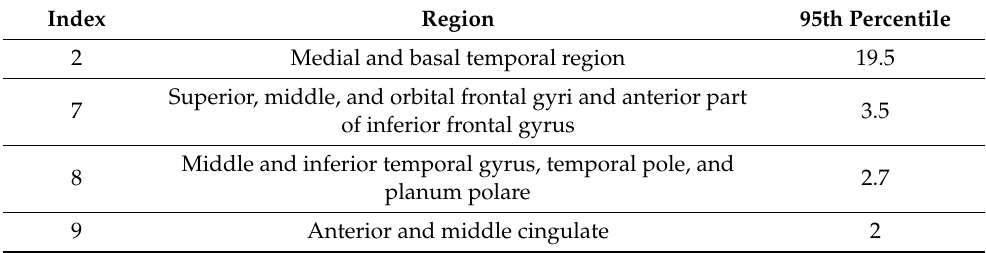
Table 2. Different ripple rate in different